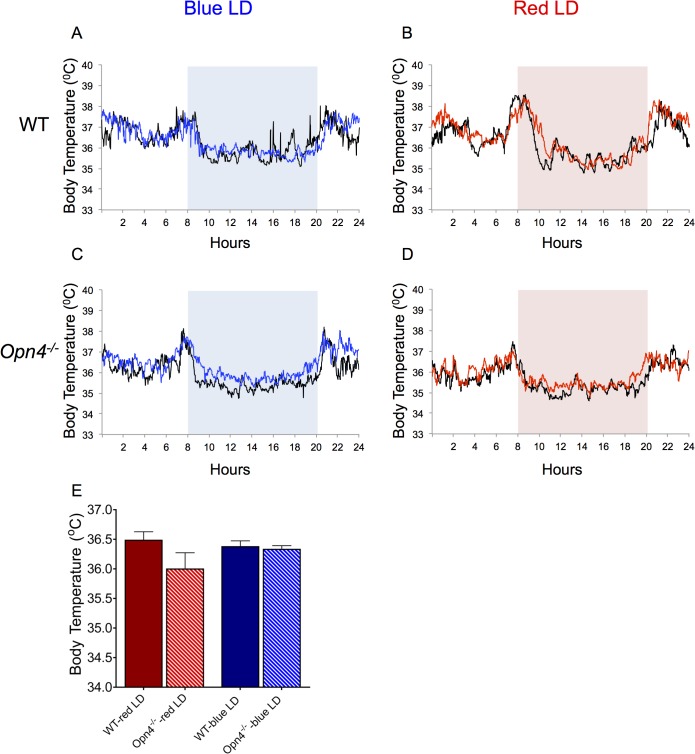
Animals assessed for entrainment as in Fig 3 were simultaneously assessed for body temperature by radio-telemetry.
Opn4
-/- mice, like WT animals, can entrain their body temperature rhythms to both red and blue LD cycles. Black traces represent one day temperature records from animals 10 days prior to KD challenge and concurrent transfer to a red or blue LD cycle. Colored traces represent one day temperature records from animals 10 days after the initiation of KD challenge and concurrent transfer to a red or blue LD cycle. Rectangles correspond to the time during which lights were on. All animals were entrained to all light conditions, exhibiting lower body temperatures throughout the light portion of the day, and peak temperatures around lights on and off. A) Wild type, before (black) and after (blue) blue LD exposure. B) Wild type, before (black) and after (red) red LD exposure. C) Opn4
-/-, before (black) and after (red) red LD exposure. D) Opn4
-/-, before (black) and after (red) red LD exposure. E) Opn4
-/- animals did not have significantly different average body temperatures than their wild type controls in either blue or red LD cycles. All values represent group means with ±SEM. (t-tests used to compare average temperatures in each light and genotype group. Under red LD cycle: Opn4
-/- n = 4, WT n = 5. Under blue LD cycle: Opn4
-/- n = 4, WT n = 4.)